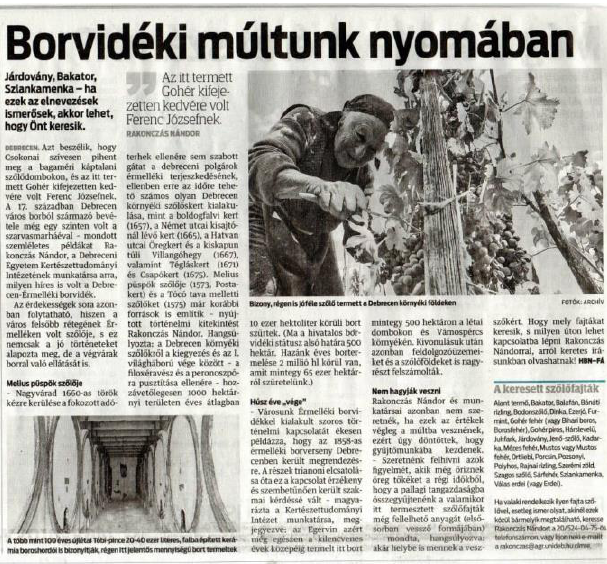
Figure 5. Announcement of the collecting work in the local newspaper in 2014 (Fabók,